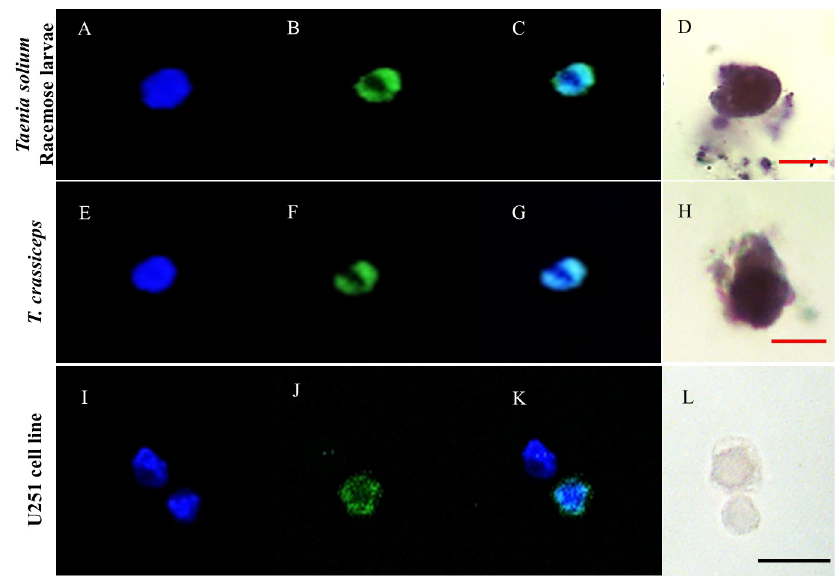
Fig 6. Proliferative cells isolated from Taenia solium racemose larvae and Taenia crassiceps cyst. Culture of cells isolated from racemose larvae and from T . crassiceps cyst by enzymatic digestion. The nuclei were stained with DAPI (A,E,I), and for the presence of phospho histone H3 (B,F,J), the merge of both signals (C,G,K) was observed with confocal microscope. Separate cells (D,H) were tested for plk1 transcripts ( in situ ). The human glioblastoma cell line U251 was used as a control for proliferation (J,K) and specificity (L). Red scale bar: 10 μ m; Black scale bar: 20 μ m. https://doi.org/10.1371/journal.pntd.0009303.g006 or T . crassiceps cell cultures perhaps because of slow growth and sparse density. The addition of insulin at 35 pmol/L produced a significant increase in the growth of racemose larvae cells after 24 hours and at 70 pmol/L after 72 hours (Fig 9A). T . crassiceps cell only showed a